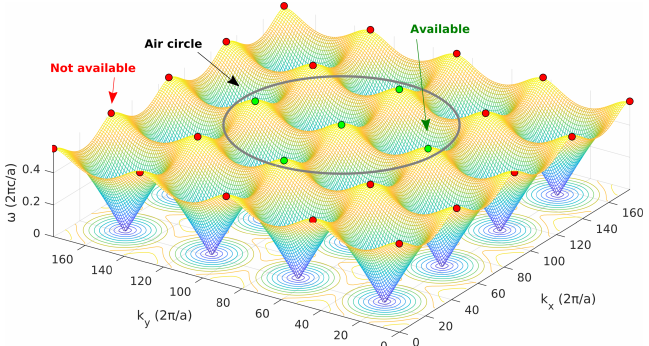
Figure 6. Ewald construction superimposed on the first Bloch mode of the system, shown for many periods of the system. For an incoming wave coupling to the central green point, several other degenerate states are created: those lying inside the air circle will be transmitted outside the medium (green point), while the others will be reflected back (red point), because of the too large k || (see the text and Figure